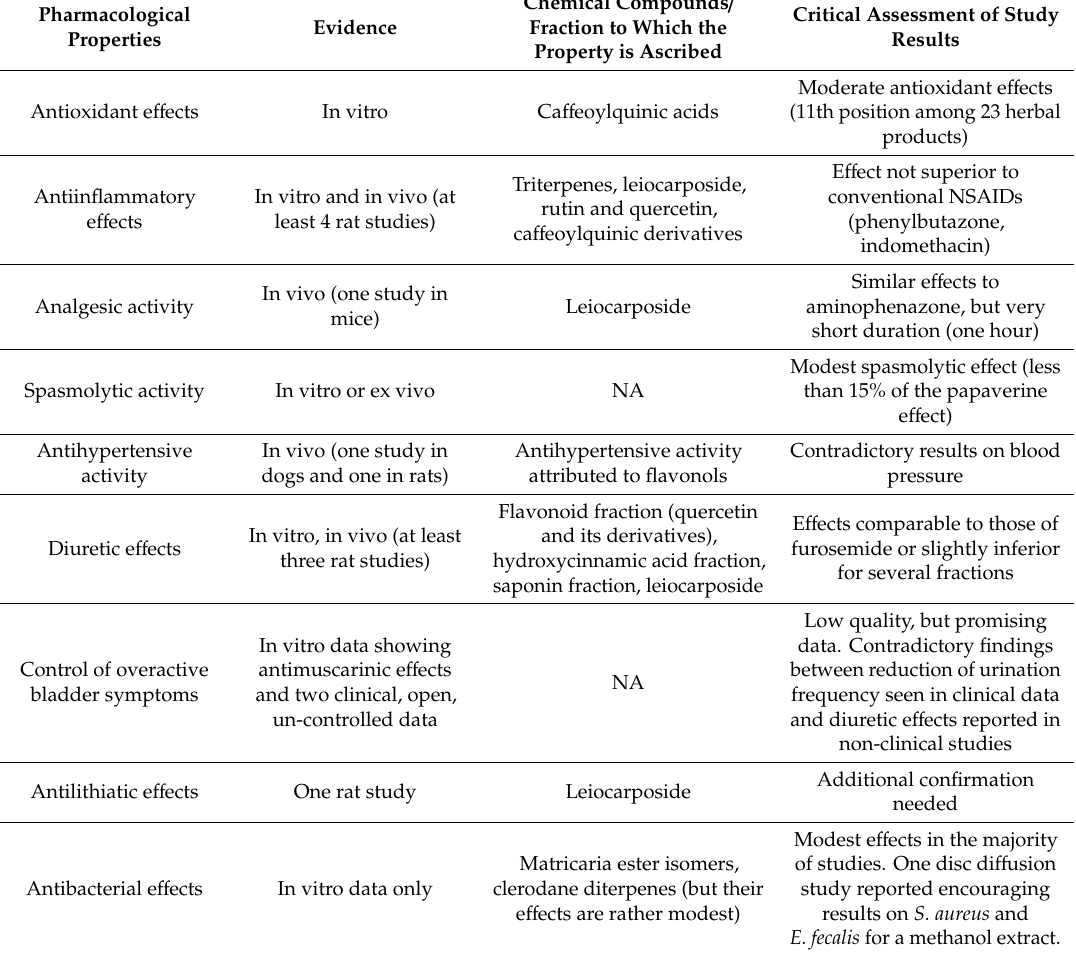
Table 3. A summary of the pharmacological properties of extracts and fractions obtained from S. virgaurea